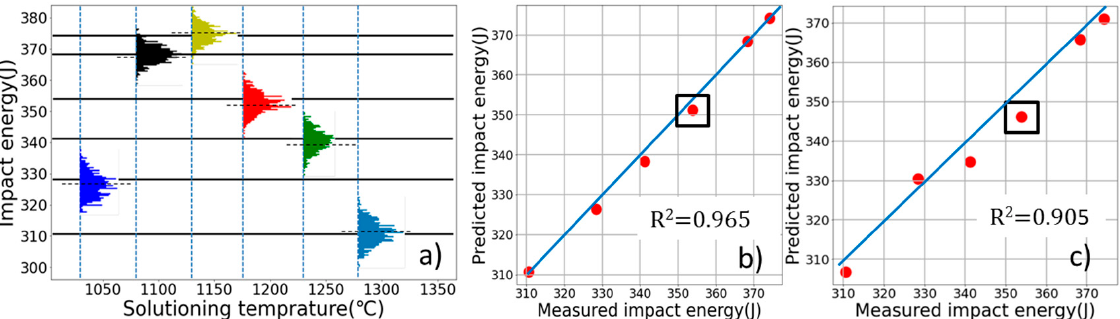
Figure 7. The results obtained by the 1500 leave-one-out cross-validation data are shown in ( a ) by the violin plot. The dotted lines in ( a ) indicate the medians. Only the medians with modified VGG and conventional VGG are plotted in ( b , c ). Coefficients of determination (R 2 ) are written in ( b , c ).